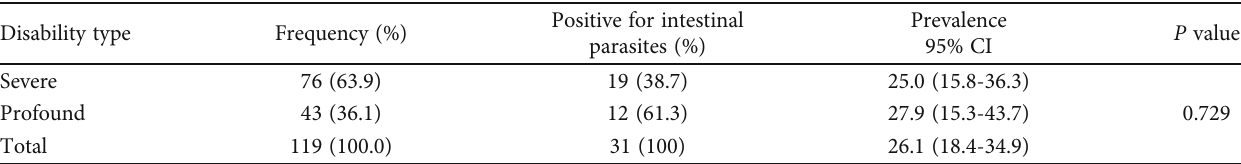
Table 5: Frequency of parasitic infections, based on the intellectually disabled type, among intellectually disabled individuals in Bandar Abbas County, Southern Iran.